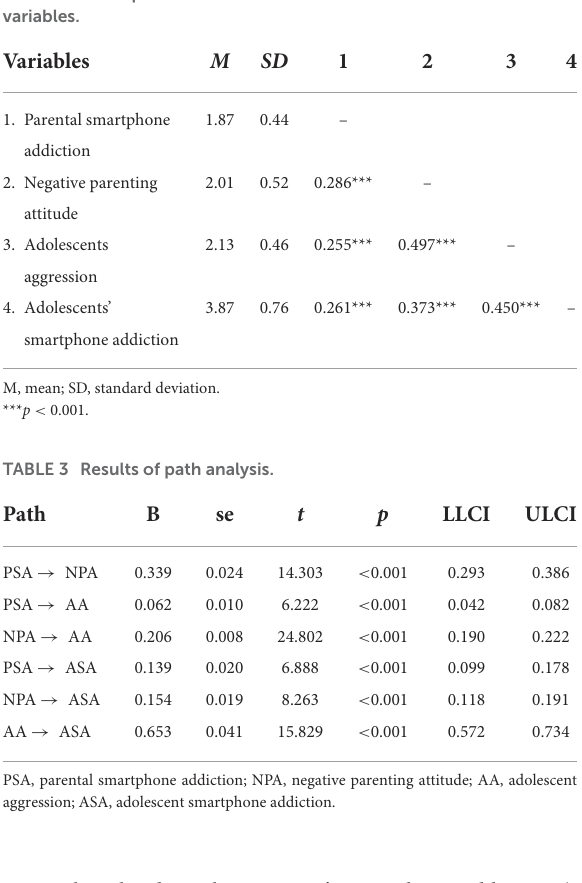
Table 4. The path where parents’ smartphone addiction